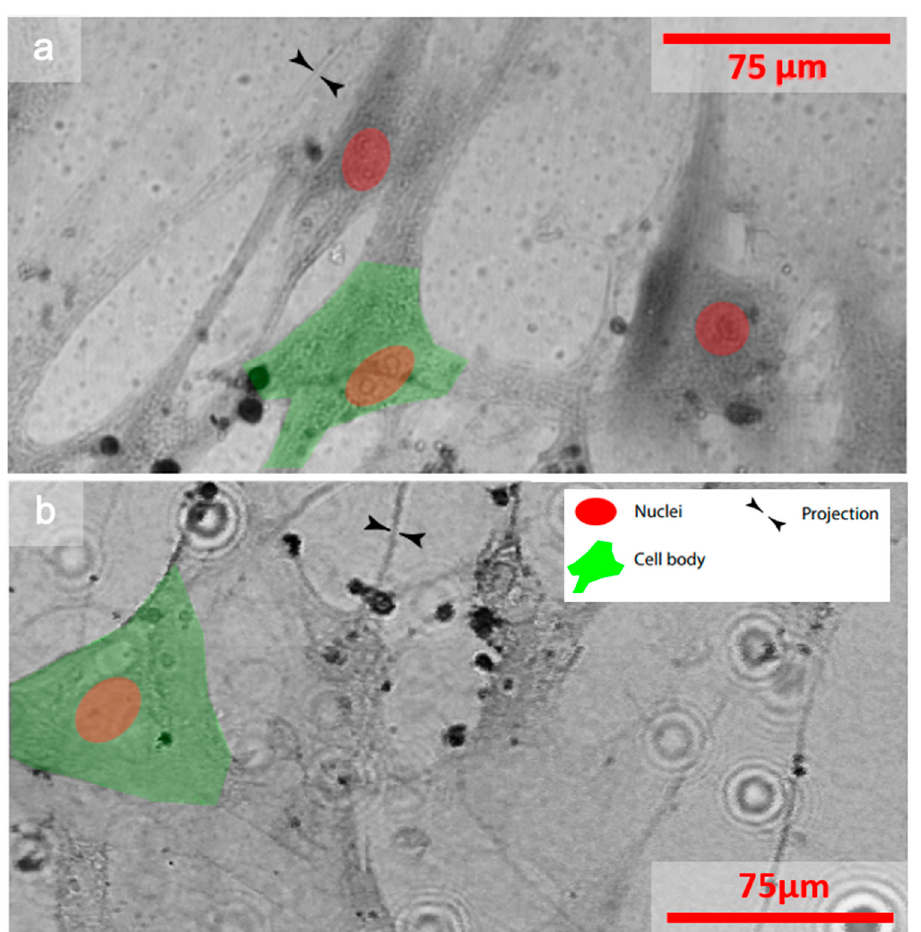
Figure 6. Human lung fibroblasts observed with a ( a ) confocal laser scanning microscope (CLSM) and ( b ) STOM microscope using a diffracted spot of 750 nm and a step size of 600 nm.